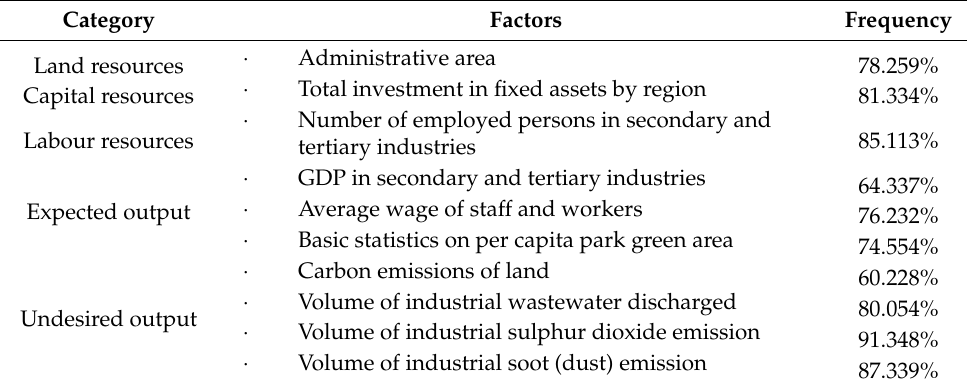
Table 2. Factors of